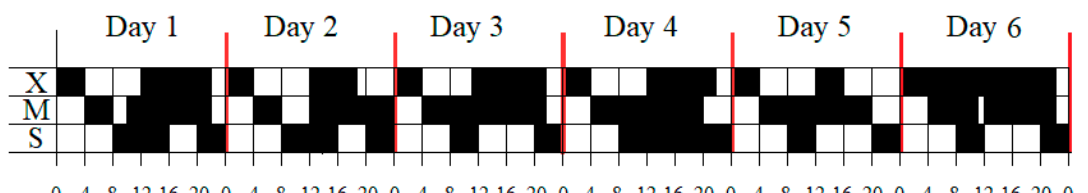
Figure 9. The real program of the subjects during the studied period, X—Coxswain, M—Mechanic, S—Sailor, ■ —Work and □ —Rest/Sleep.